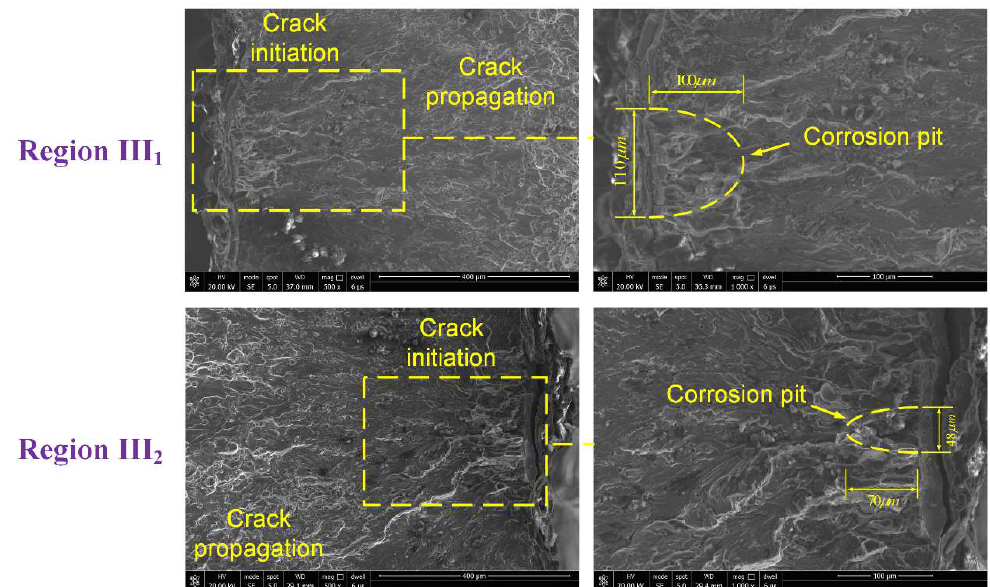
Figure 12. Fracture morphology of specimen with a corrosion time of 96 h.